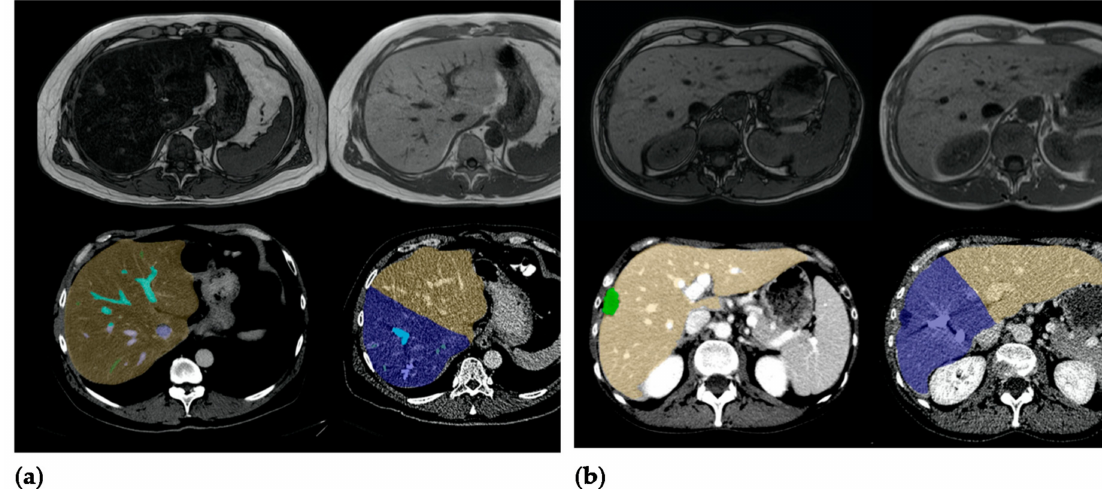
Figure 2. ( a ) Patient A, a 59-year-old male patient with steatosis (hFF 40.2%), hypertrophy rate 40.9%. ( b ) Patient B, a 47-year-old female patient without elevated hepatic fat fraction (hFF 4.9%), hypertrophy rate